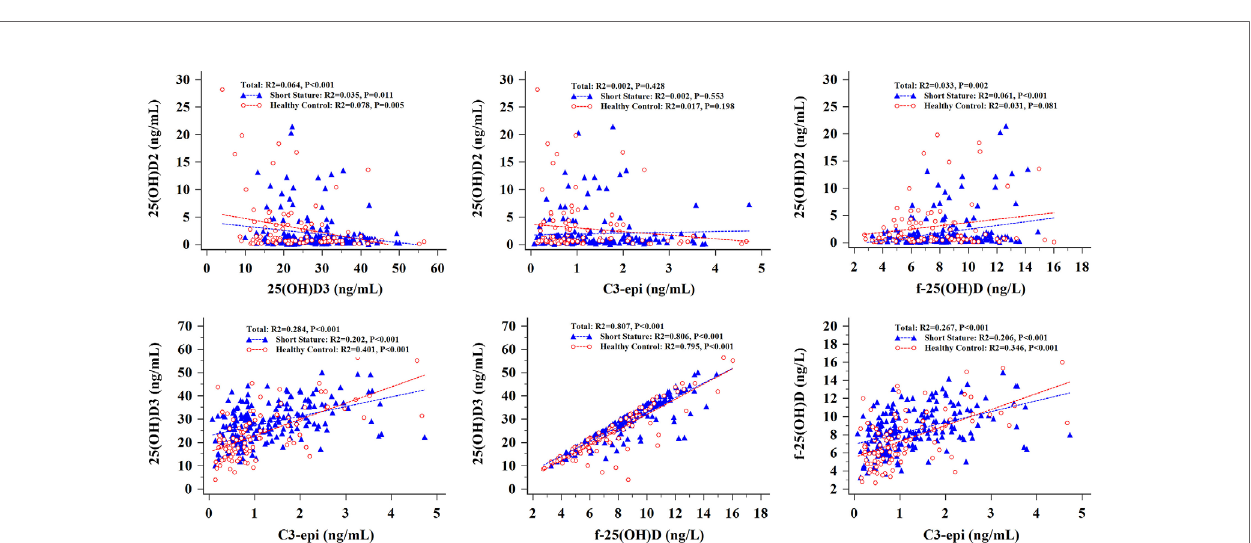
FIGURE 2 | Correlation analysis of various vitamin D components in short stature and healthy control groups.